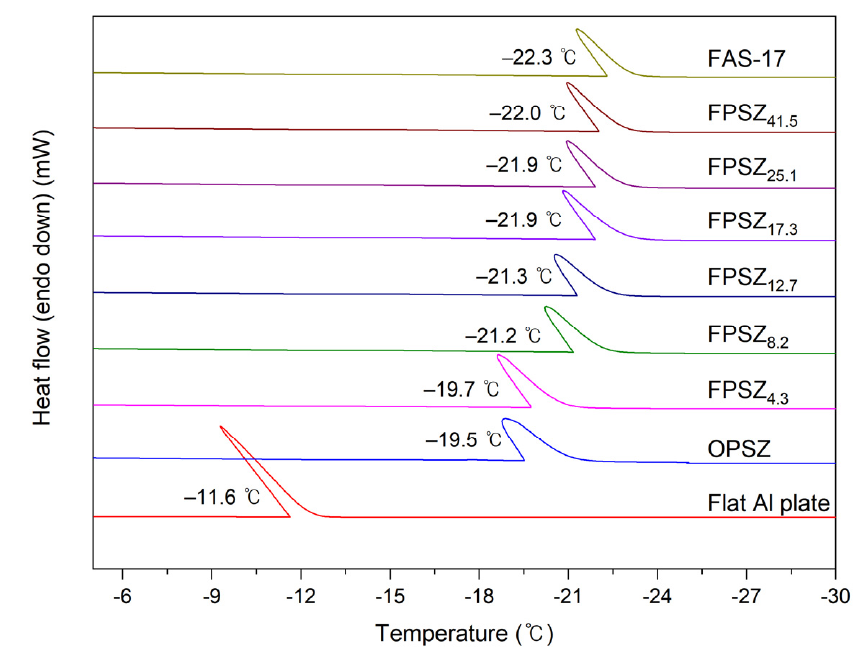
Figure 5. DSC curves of super-cooled water droplets dripped on the OPSZ-, FPSZ-, and FAS-17- coated rough Al surfaces. A flat Al substrate was used for comparison. The temperature was set to decrease at a rate of 10 °C min − 1 .